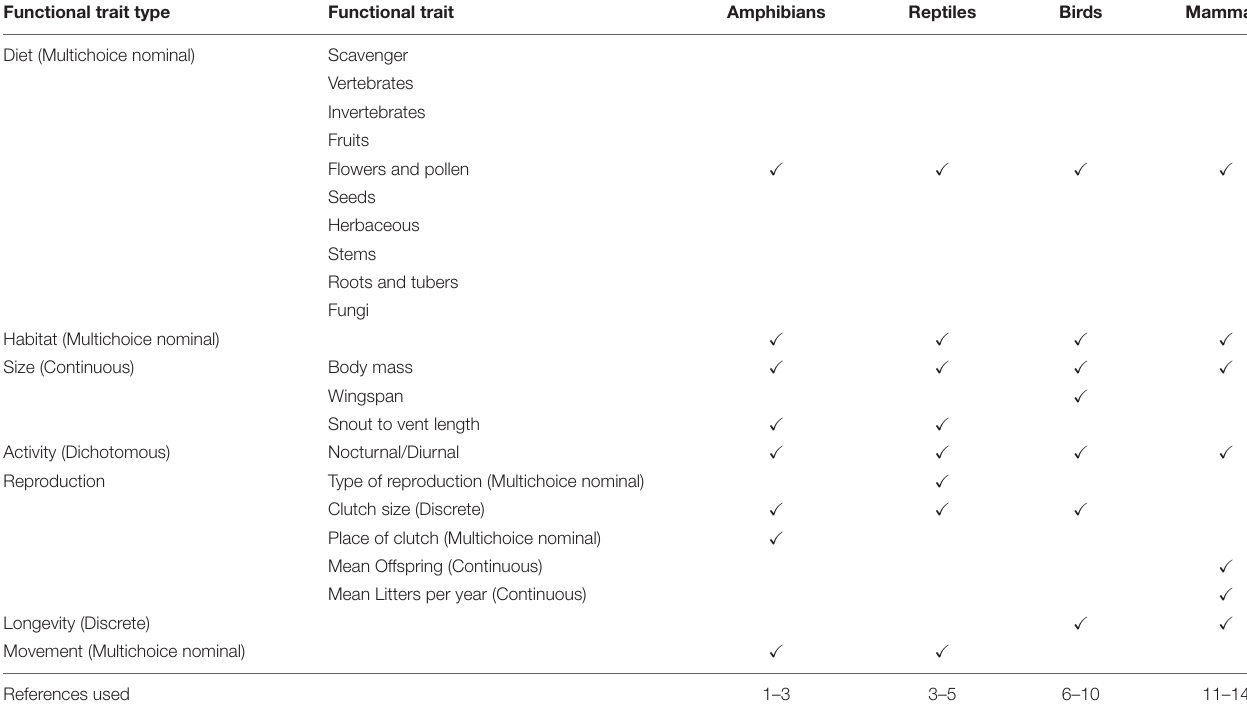
TABLE 1 | Functional traits compiled for amphibians, reptiles, birds, and mammals using different sources: 1-García-París et al., 2004; 2-Trochet et al., 2014; 3-Carvalho et al., 2017; 4-Grimm et al., 2014; 5-Salvador, 2014; 6-Cramp et al., 2004; 7-Dunning, 2008; 8-Wilman et al., 2014; 9-Hume, 2016; 10-SEO - Sociedad Española de Ornitología, 2018; 11-Palomo et al., 2007; 12-Aulagnier, 2009; 13-Jones et al., 2009; 14-Safi et al., 2011. Functional trait